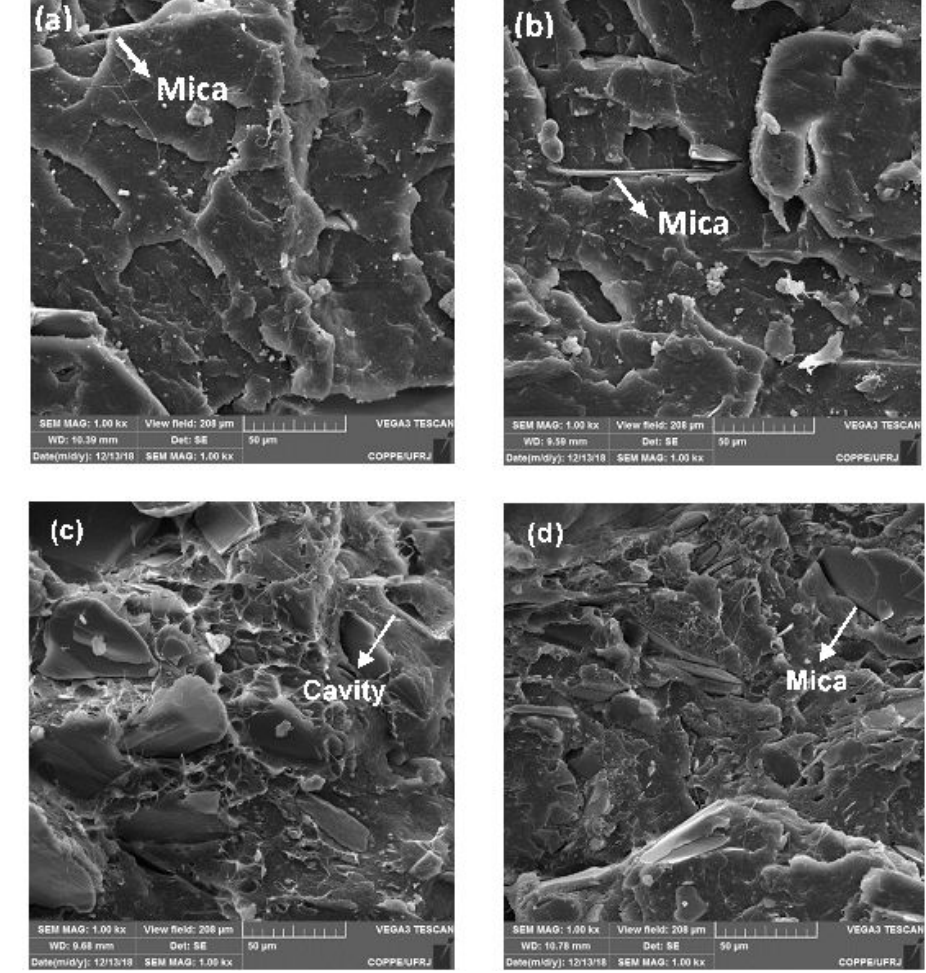
Figure 2. SEM micrographs of fractured surfaces of rHDPE/mica: (a) 95/5; (b) 90/10; (c) 85/15 and (d) 80/20